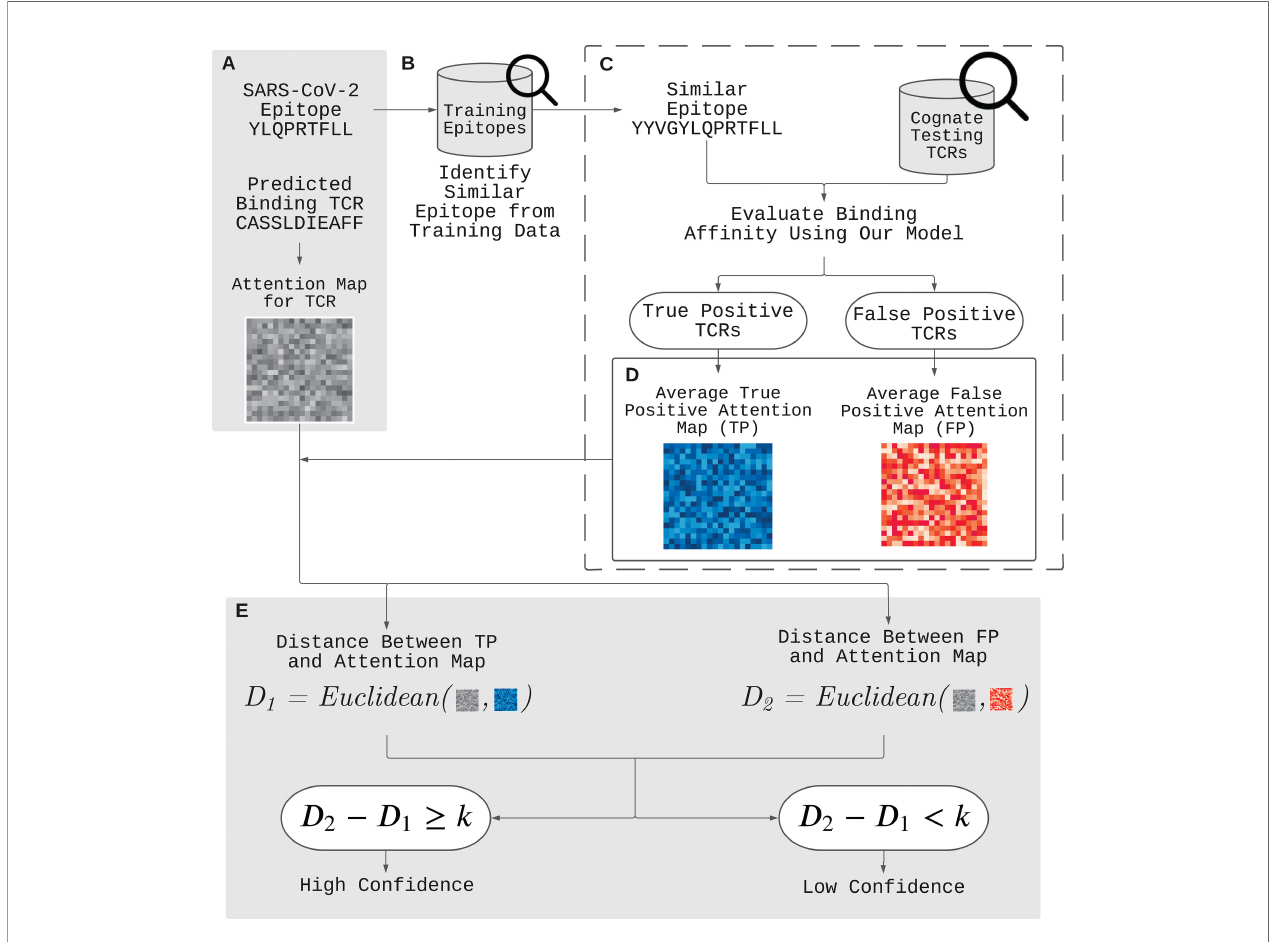
FIGURE 2 | Improvement of out-of-sample prediction using attention maps. (A) We have a positively predicted (binding af fi nity score > 0.5) pair of a novel epitope (YLQPRTFLL) and TCR (CASSLDIEAFF) by ATM-TCR. In order to further validate the prediction, we utilize the attention map and determine its binding con fi dence level by comparing it with two reference attention maps for true and false positives. (B) We identify a reference epitope (YYVGYLQPRTFLL) from the dataset having the maximal longest common subsequence with the novel epitope. (C) We then evaluate the binding af fi nity between the reference epitope and each TCR in the data, and obtain the attention maps for the TCRs predicted as positive. (D) The TCRs are placed in two categories: one for true positive and another for false positive TCRs. The attention maps in each category are averaged together to create true positive and false positive reference attention maps. (E) If the Euclidean distance between the TCR ’ s (CASSLDIEAFF) attention map and the true positive representative map ( D 1 ) is closer then that of the false positive representative map (